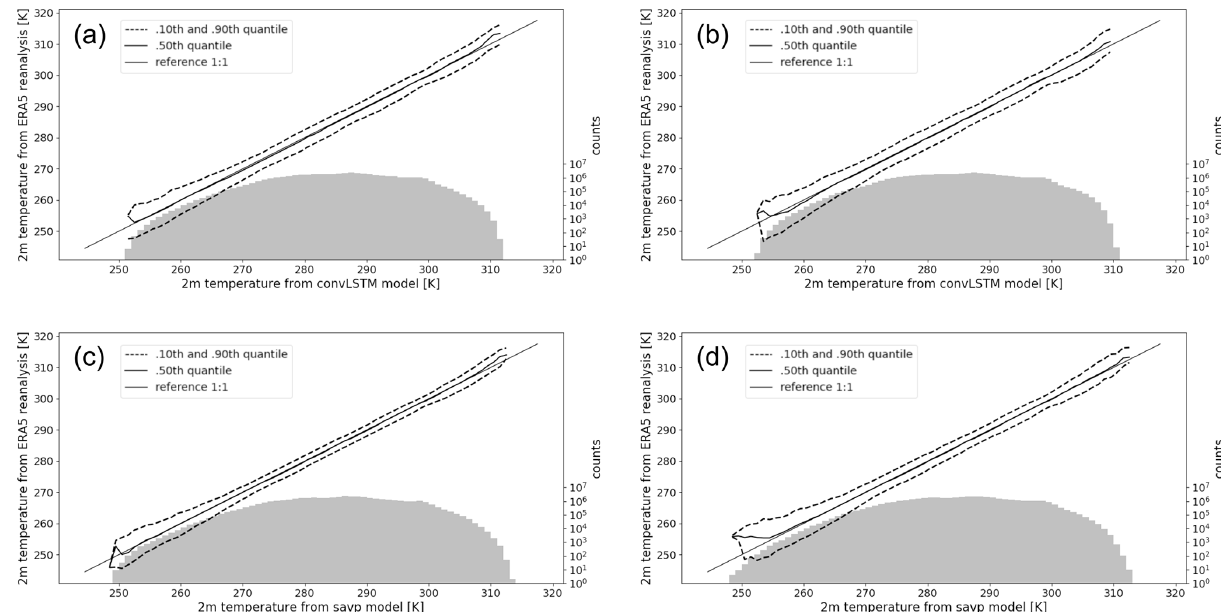
Figure 7. Conditional quantile plots in terms of the calibration-refinement factorization for 2m temperature forecasts with a lead time of 6h (a, c) and 12h (b, d) . Panels (a, b) show the factorization of ConvLSTM forecasts, while (c, d) correspond to the SAVP model. The solid straight line denotes the 1 : 1 reference line of a hypothetical perfect model. The dashed lines represent the 10th and 90th quantiles, and the bold solid line represent the median of the ground truth data conditioned on the forecasts, respectively. The marginal distribution of the model forecasts is presented as log histogram (right axis, light grey